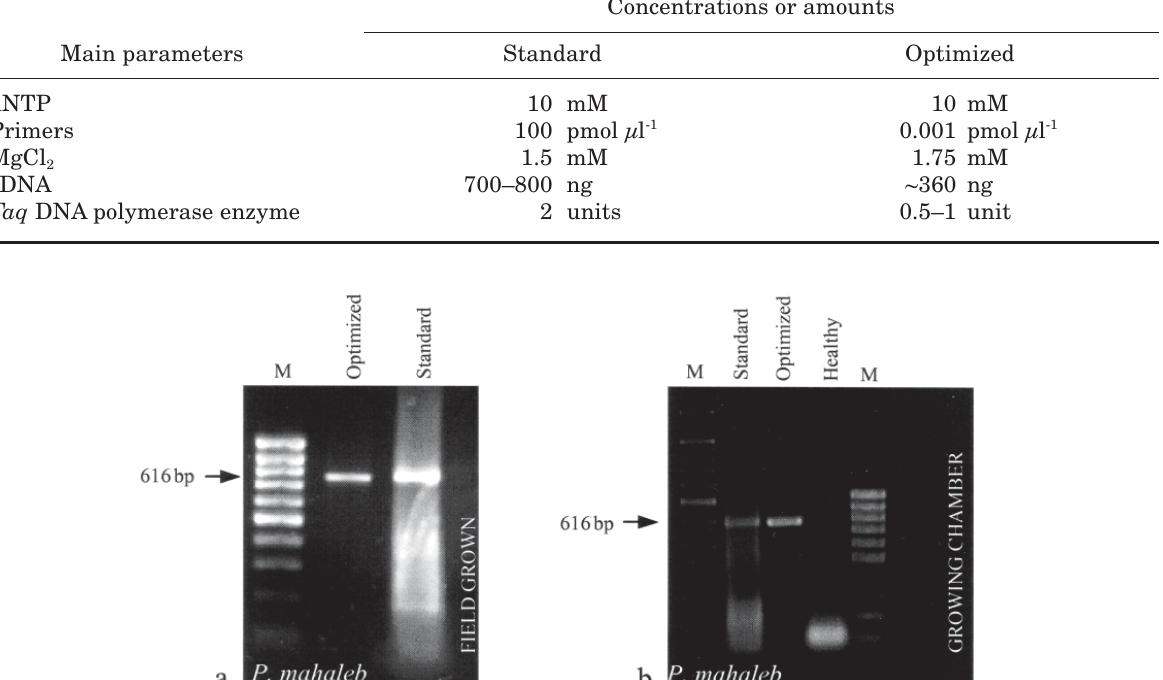
Table 1. Optimum concentrations of PCR parameters obtained throughout the RT-PCR reactions. Concentrations or amounts